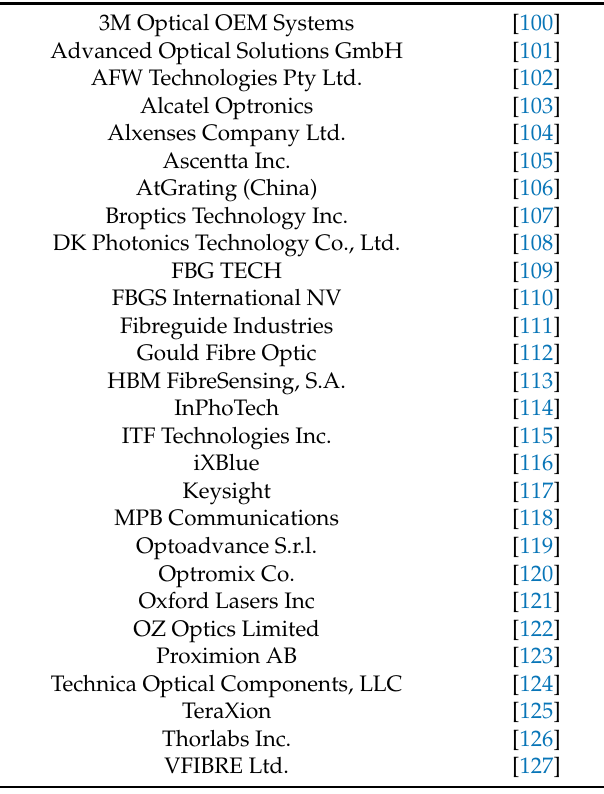
Table 5. The main market